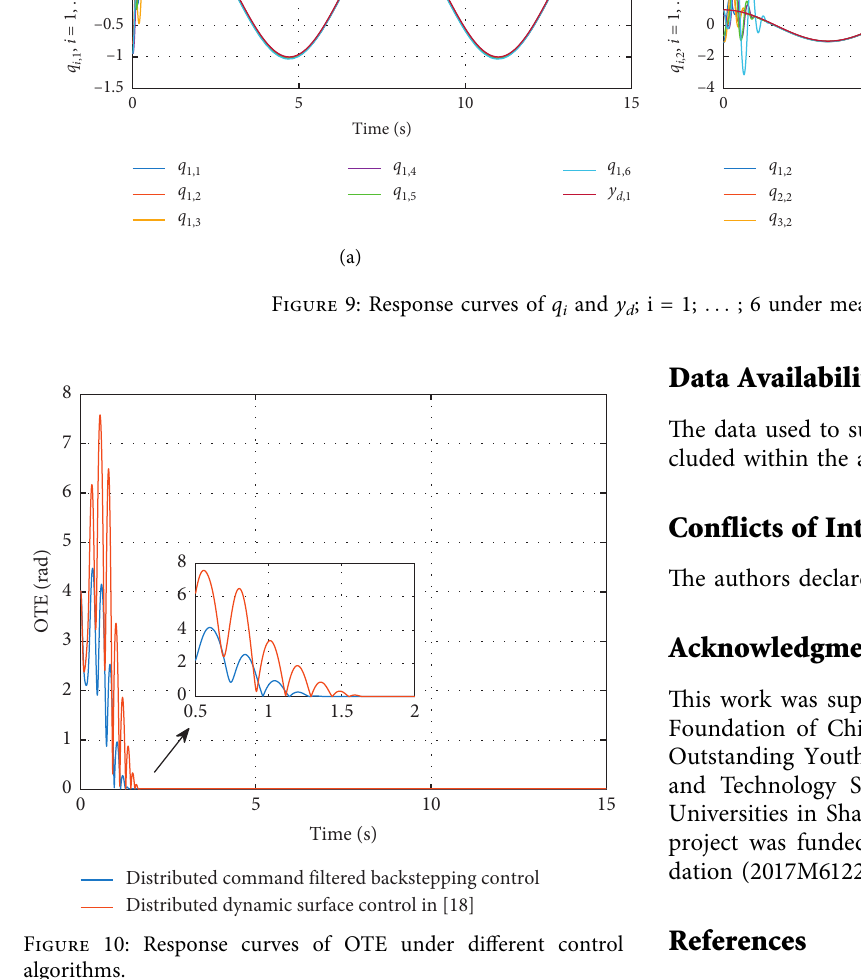
Figure 10: Response curves of OTE under different control